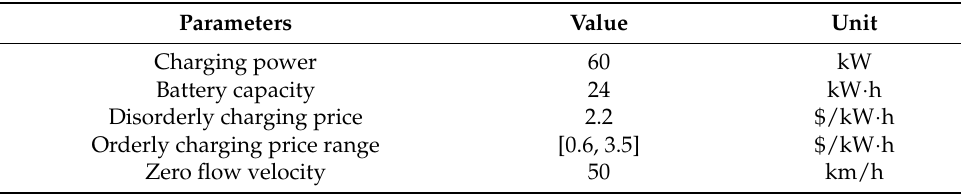
Table 1. Value of main parameters in the